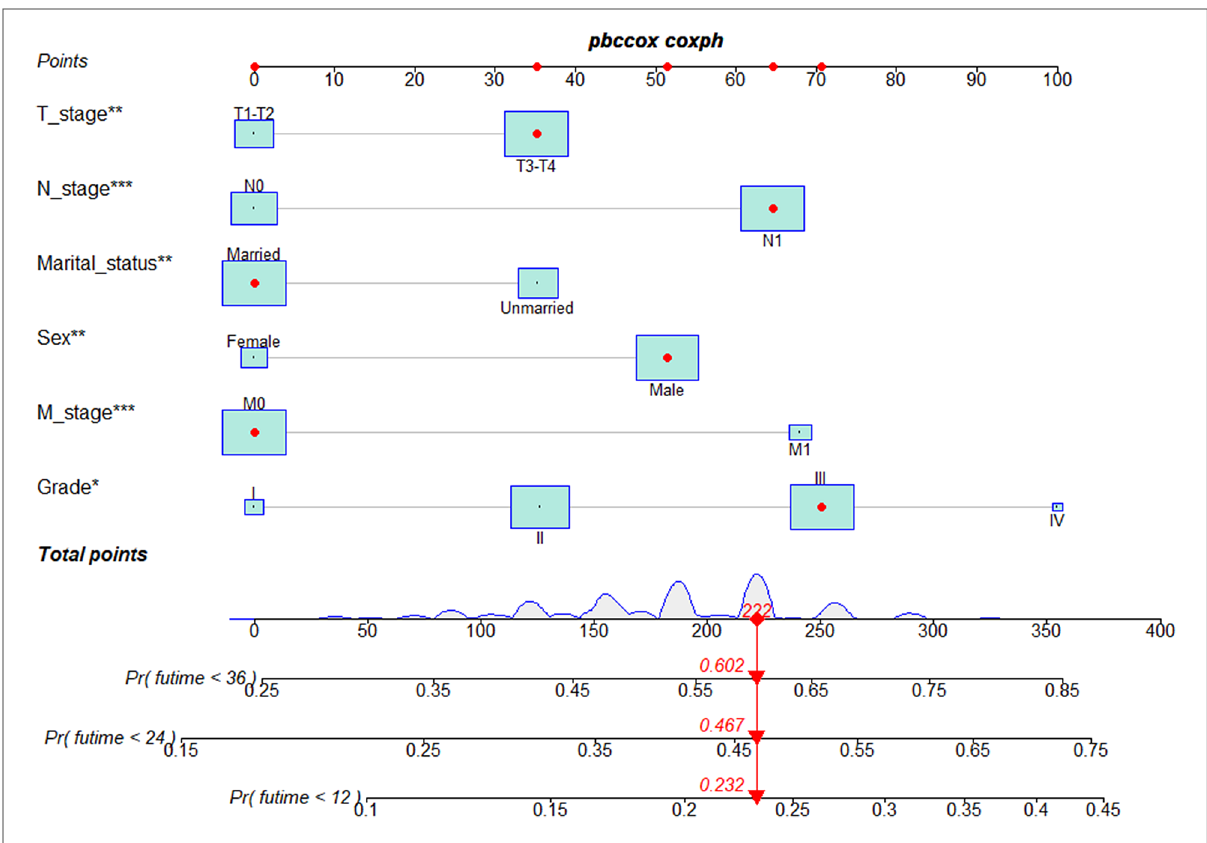
FIGURE 1 Nomogram predictive models for 1 -, 2 -, and 3-year overall survival in patients with esophageal cancer receiving neoadjuvant